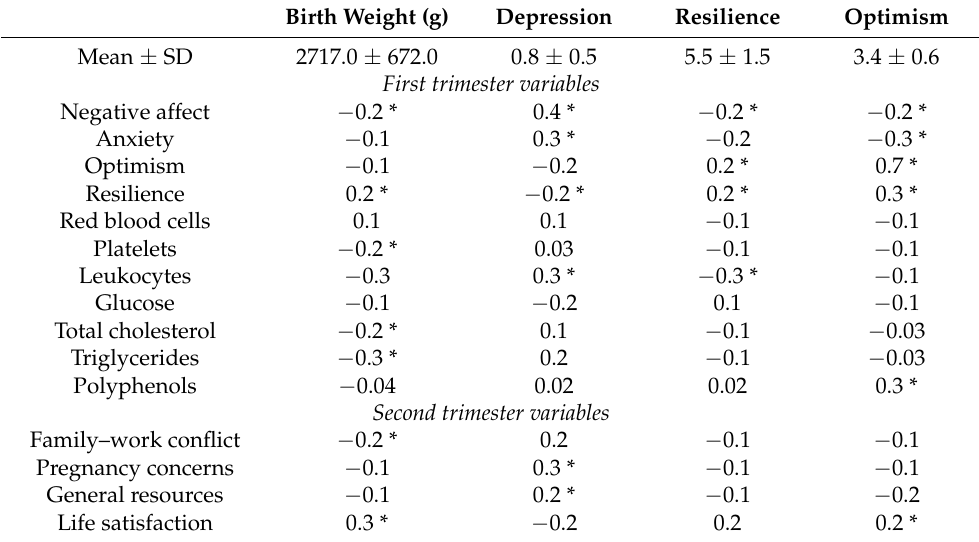
Table 1. Correlations between psychological variables and primary outcomes at the end of the study.